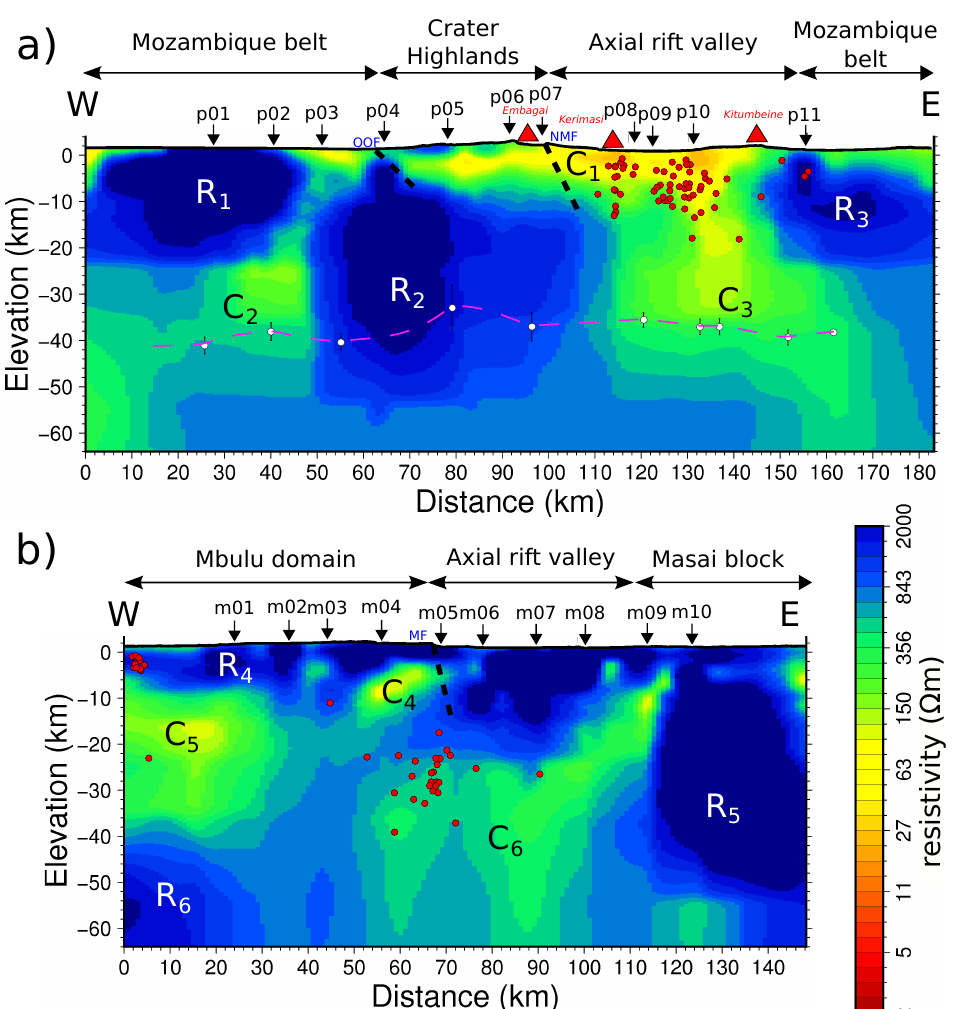
Figure 3. Electrical resistivity ∼ EW cross-sections of the two 3-D resistivity models for the Natron ( a ) and Manyara ( b ) profiles. The letters correspond to regions discussed in the text. In ( a ) the pink dashed line and the white circles indicate the position of the Moho from Plasman et al. [35], only available for the northern profile. Red dots are the earthquakes from Albaric et al. [14] relocated in a 3-D velocity model [15]. OOF: Ol Doinyo Ogol fault, NMF: Natron master fault, MF: Manyara